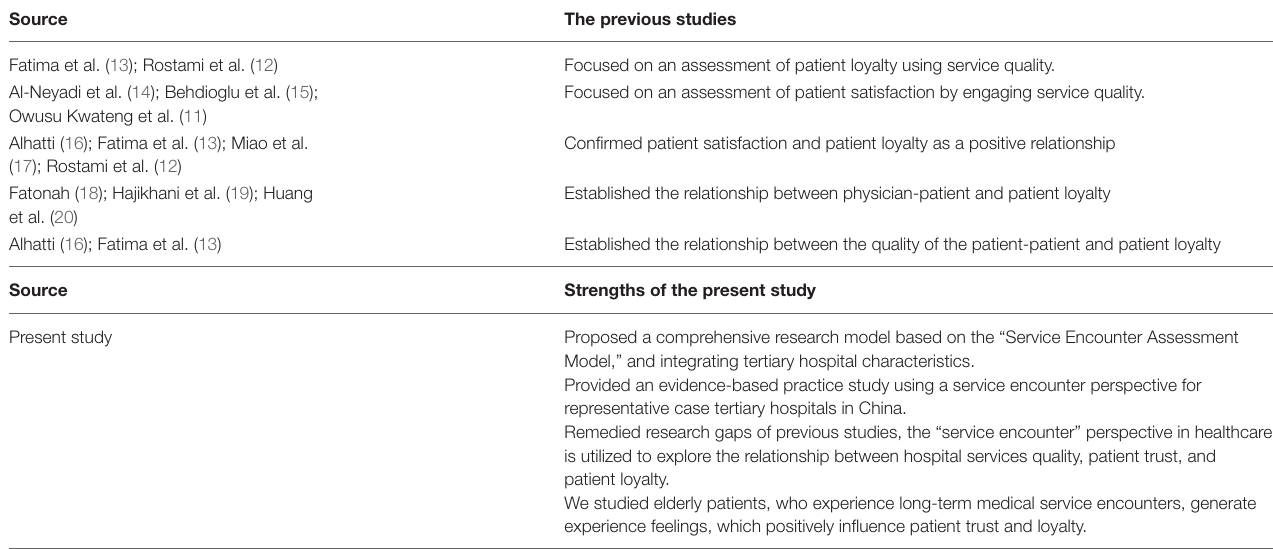
TABLE 13 | The comparison of the strengths of this study with previous studies using the service encounter perspective.